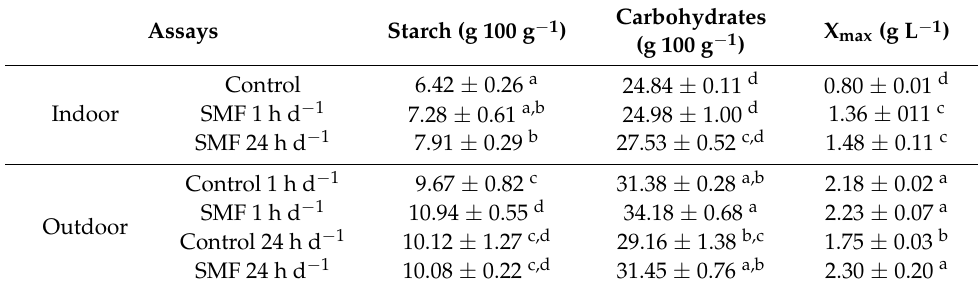
Table 1. Final biomass concentration (X max ), total carbohydrates and starch contents in Chlorella fusca LEB 111 biomass cultivated under different conditions of static magnetic field (SMF) application.